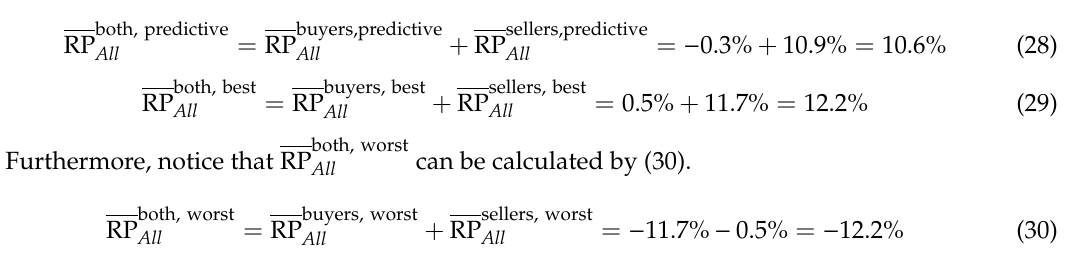
Figure 8. Risk Premium for sellers.